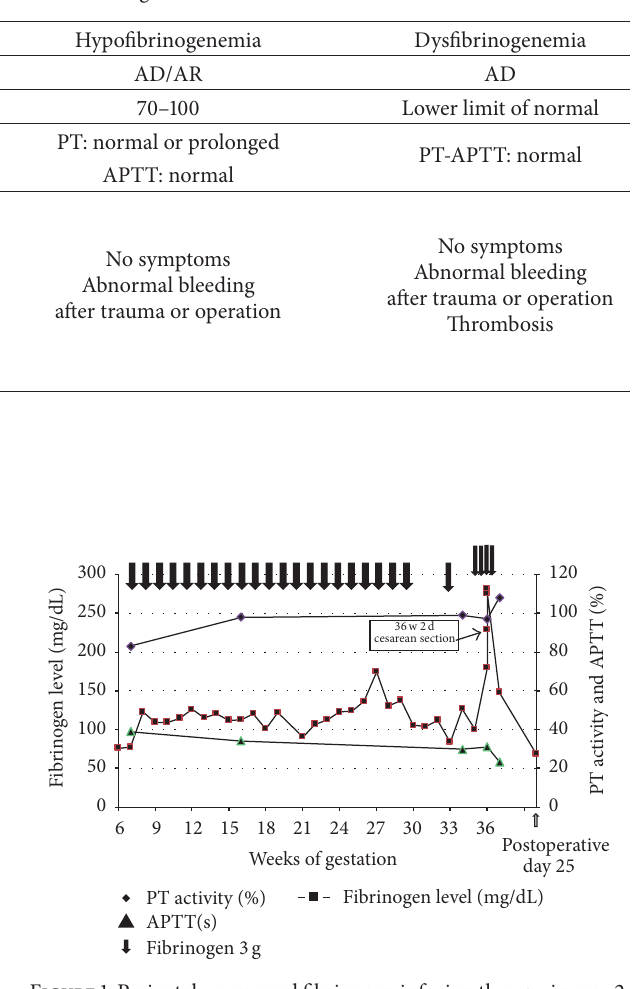
Figure 1: Perinatal course and fibrinogen infusion therapy in case